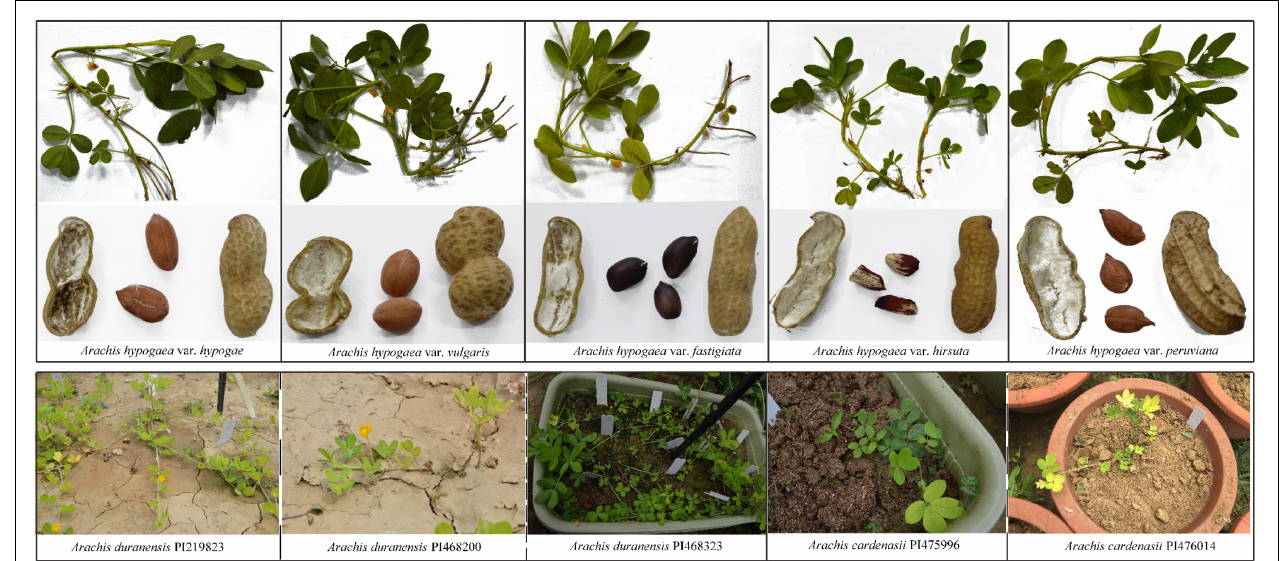
FIGURE 5 | Morphological differences among selected Arachis species (three accessions of A. duranensis , two accessions of A. cardenasii and five cultivated